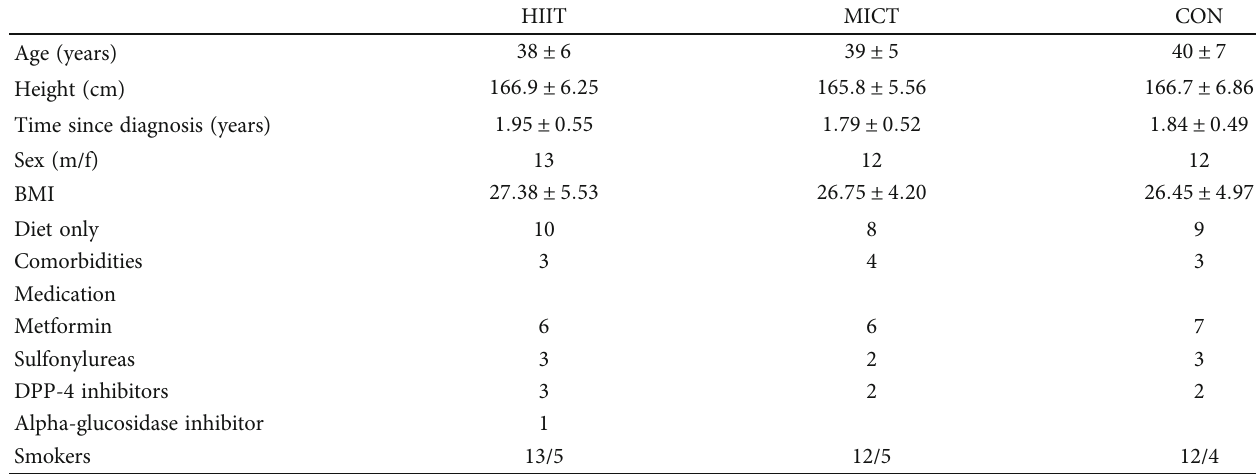
Table 1: Participant